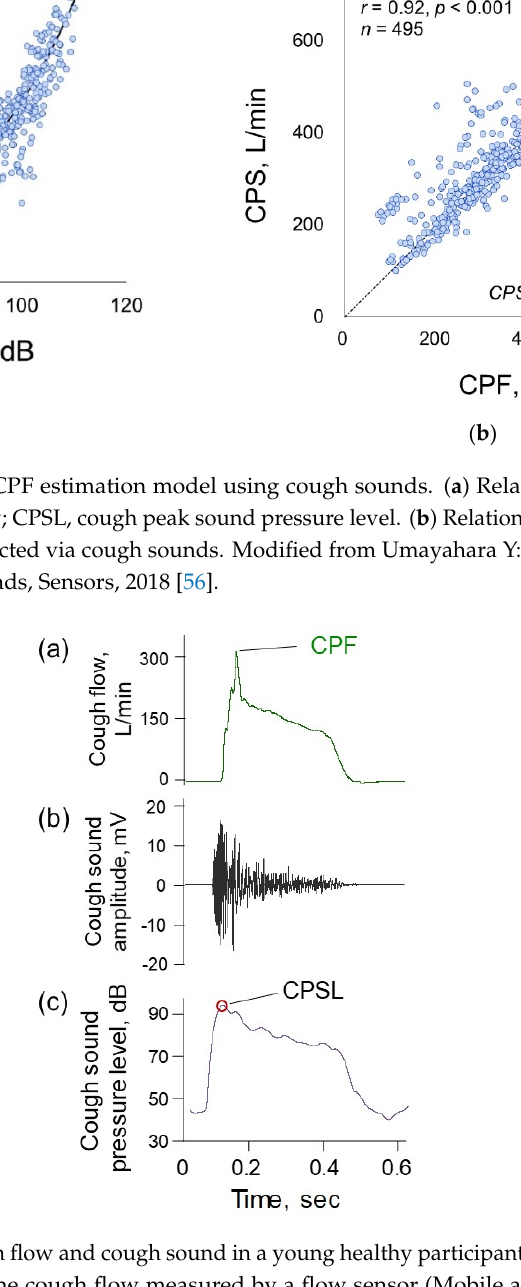
Figure 3. Accuracy of the CPF estimation model using cough sounds. ( a ) Relationship of CPF and CPSL. CPF, cough peak flow; CPSL, cough peak sound pressure level. ( b ) Relationship of CPS and CPF. CPS, cough peak flow predicted via cough sounds. Modified from Umayahara Y: Estimation